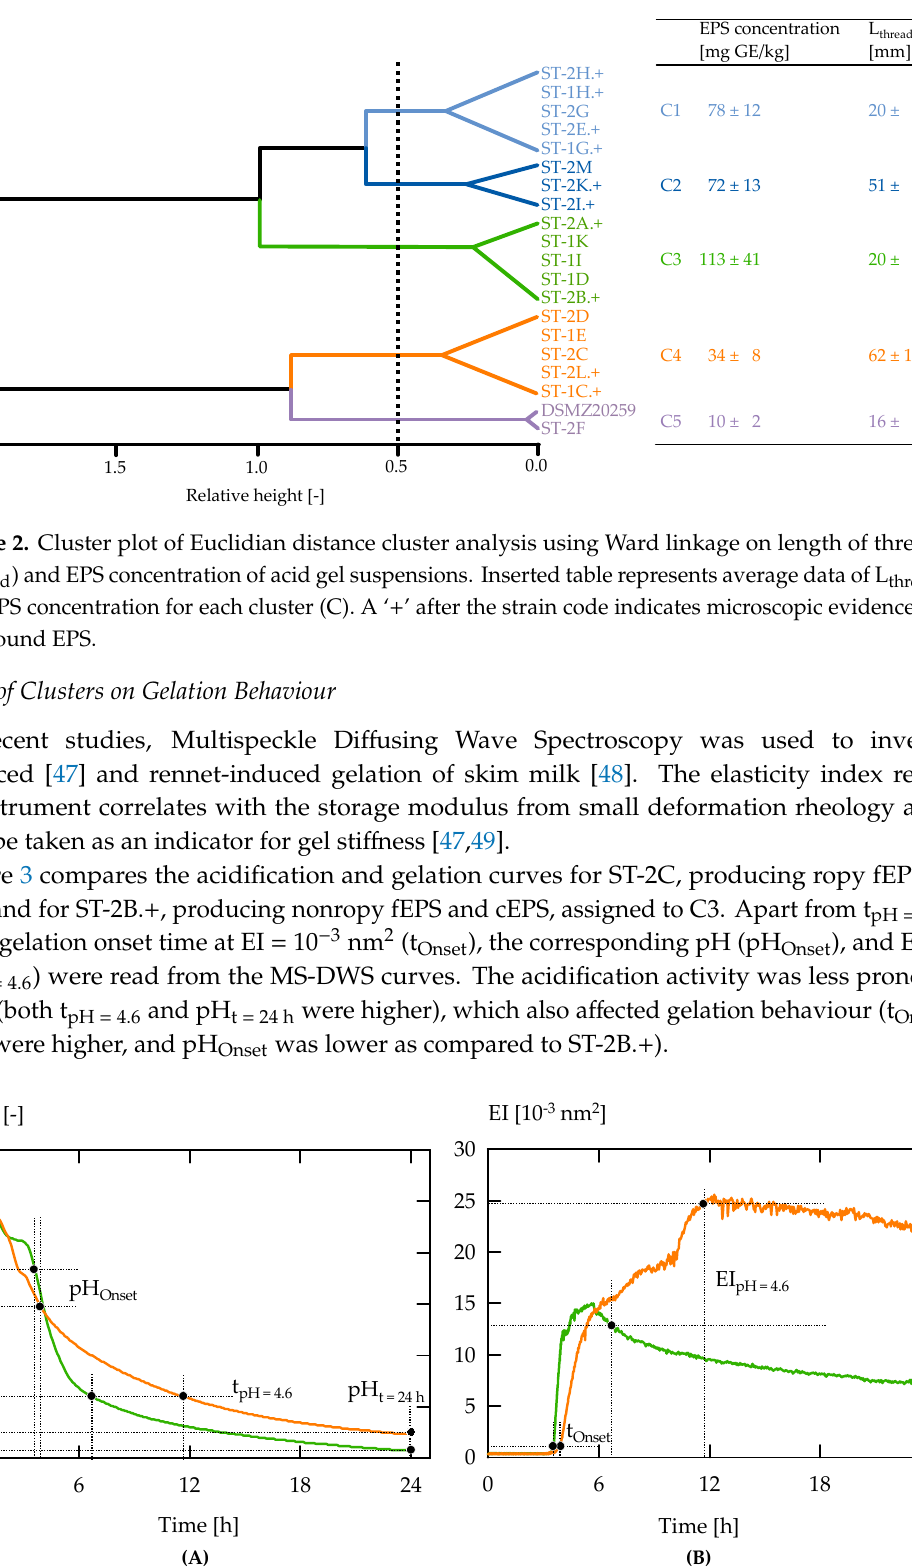
Figure 3. pH ( A ) and elasticity index (EI) ( B ) during acidification of reconstituted skim milk with ST ‐ 2B.+ (green) and ST ‐ 2C (orange). Parameters obtained are time until pH 4.6 (t pH = 4.6 ), pH at end of fermentation (pH t = 24 h ), gelation onset at EI = 10 ‐ 3 nm 2 (t Onset ) and corresponding pH (pH Onset ), EI at pH 4.6 (EI pH = 4.6 ). Curves are representative runs (see Figure 4 for statistical analysis).